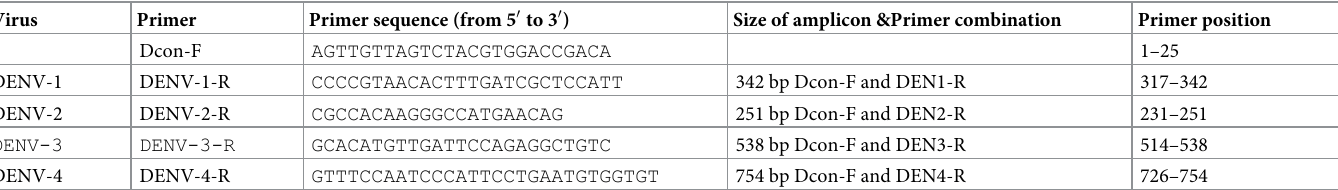
Table 1. Primer sequence, and size of RT-PCR product and generated combination of primers.